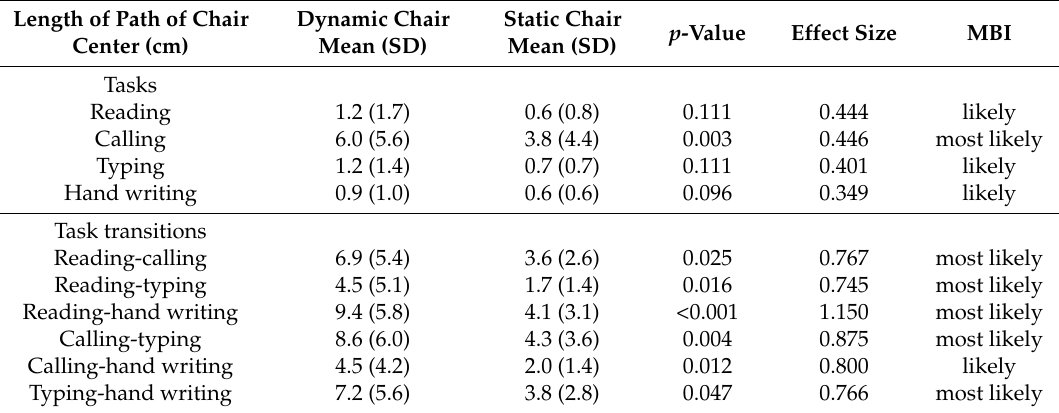
Figure 3. Relative increase in path length of the chair center for sitting on the dynamic chair compared to the static chair for the different tasks and task transitions. Table 1. Mean (1 standard deviation) length of path of the chair center while sitting on the static or dynamic chair performing the different tasks and task transitions.